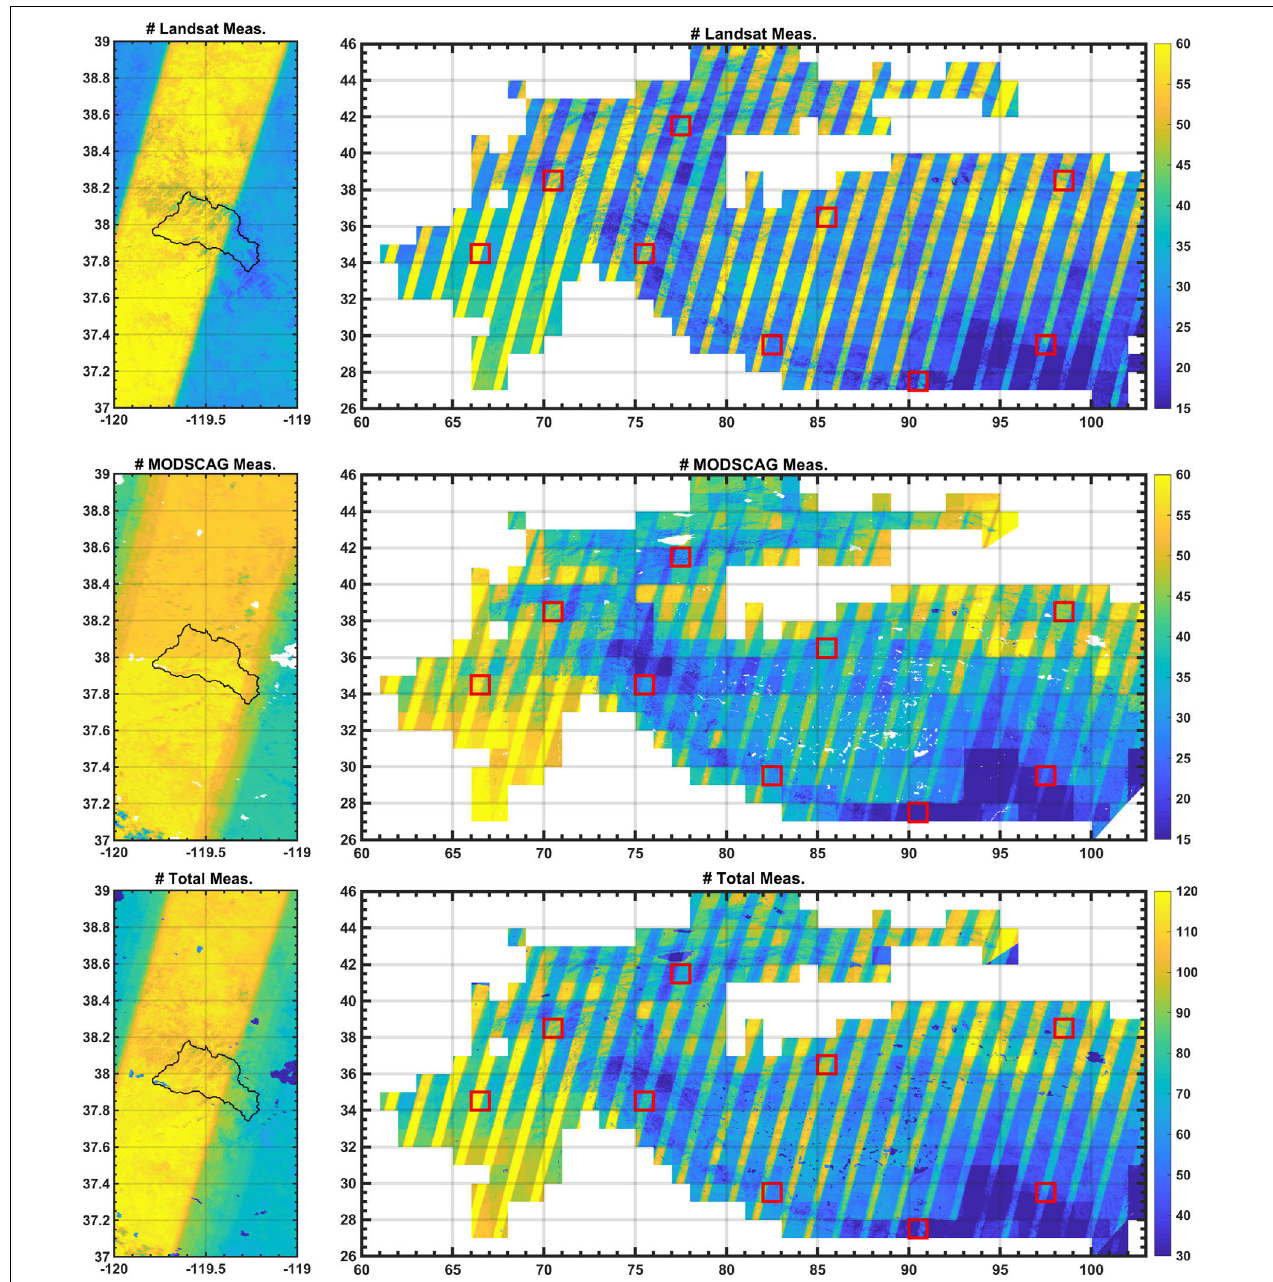
FIGURE 5 | (Top row) Number of available cloud-free Landsat measurements over Tuolumne (left) and HMA (right) domains for WY 2016. (Middle row) Number of available cloud-free MODSCAG measurements (screened for viewing zenith angles θ < 20 ◦ ) over Tuolumne (left) and HMA (right) domains for WY 2016. (Bottom row) Total number of available cloud-free Landsat and screened MODSCAG measurements over Tuolumne (left) and HMA (right) domains for WY